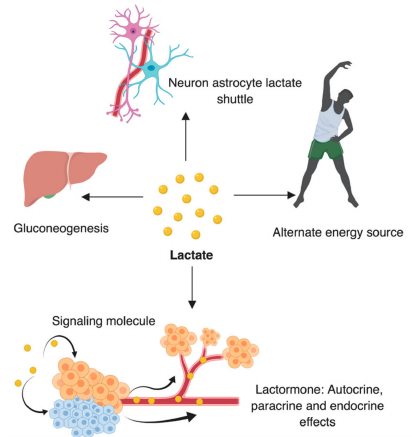
Figure 2. Physiological role of lactate in the body: Lactate acts as an alternate fuel in the body during endurance training; acts as energy source in brain through neuron astrocyte lactate shuttle; acts as a source for gluconeogenesis and also acts very often as a lactormone